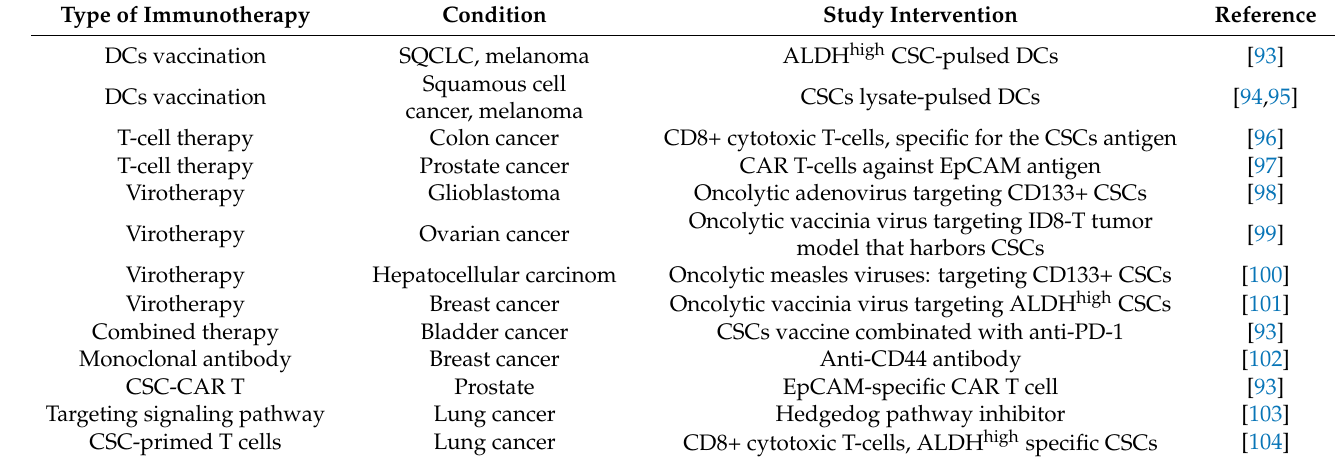
Table 3. Recent advances in targeting CSCs by immunotherapy. DCs—dendritic cells; CAR T cells—chimeric antigen receptor T cells; ID8-T—epithelial ovarian cancer cell